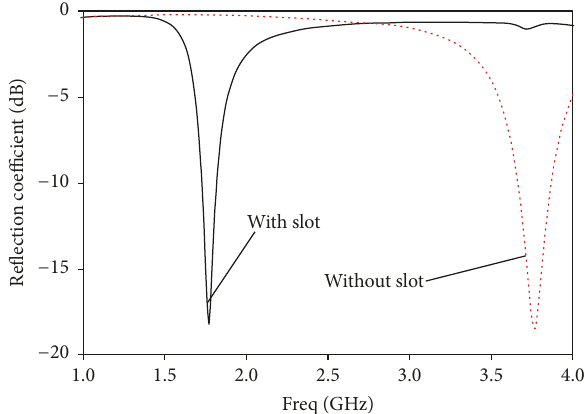
Figure 5: Variation in resonance frequency with and without slot.